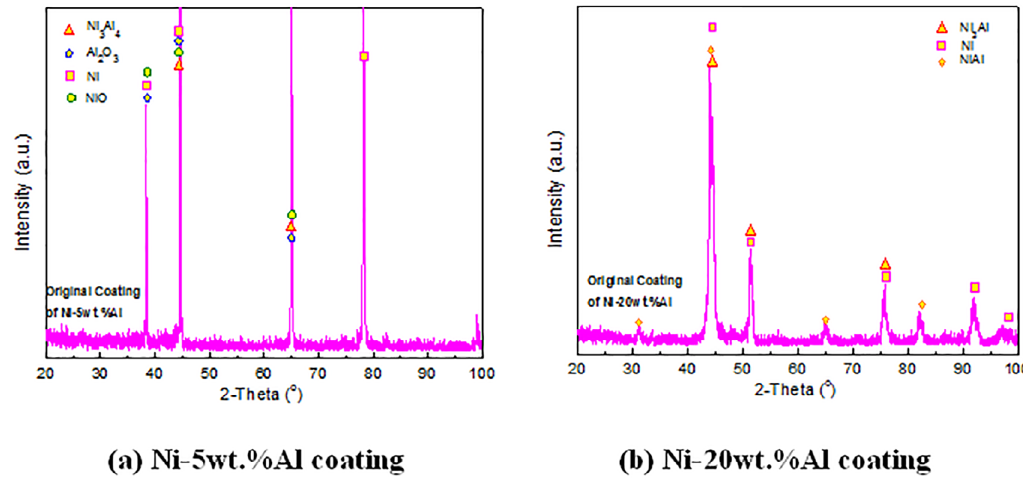
Figure 11. XRD patterns of as-prepared coating Ni-5wt.%Al and Ni-20wt.%Al for (a) and (b). Figure 12 is a TEM analysis of the original state of Ni-Al coating. In the surface layer of the coating (Ni-20wt.% Al), the amorphous phase exists in the coating (Figure 12a) as shown by the selected area electron diffraction (Figure 12b) and EDS and elemental composition (Figure 12c). Figure 13 is TEM morphology and electron diffraction of the as-prepared Ni-Al coatings. From Figure 13a, it can be seen that there are equiaxed grains (2#) in the coating and the orientation of the [011] band axis of the selected area electron diffraction is Ni substrate. The existence of amorphous and equiaxed crystals is due to the formation of sprayed particles under rapid cooling conditions. Ni-Al particles exposed to the air react with oxygen to produce equivalent heat. At the same time, the Ni-Al particles are oxidized to varying degrees. The particles are impacted on the substrate in a melting or semi-melting state to form a coating. In this very short